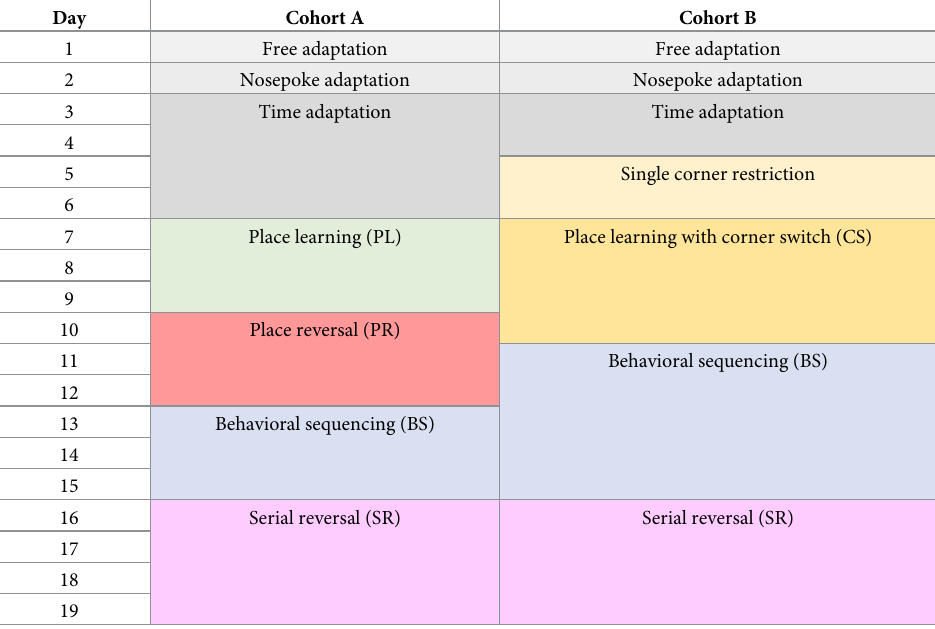
Table 2. IntelliCage program timeline overview for cohorts A and